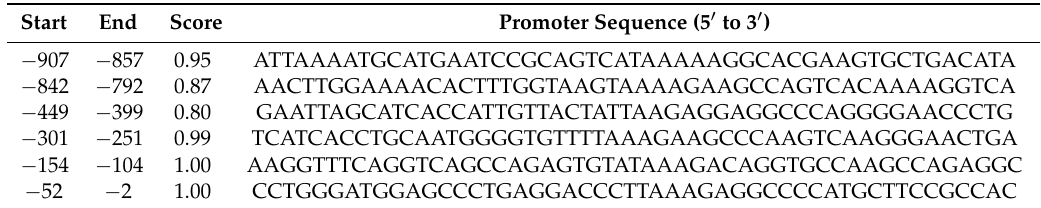
Figure 7. Transcription factor screening results. ( A ) The comparison chart of the control group and experimental group processing value of the screened out transcription factors; ( B ) The comparison chart of the control group and experimental group processing value of some transcription factors. Table 1. Sequence prediction results of uncoupling protein 3 ( UCP3) promoter.